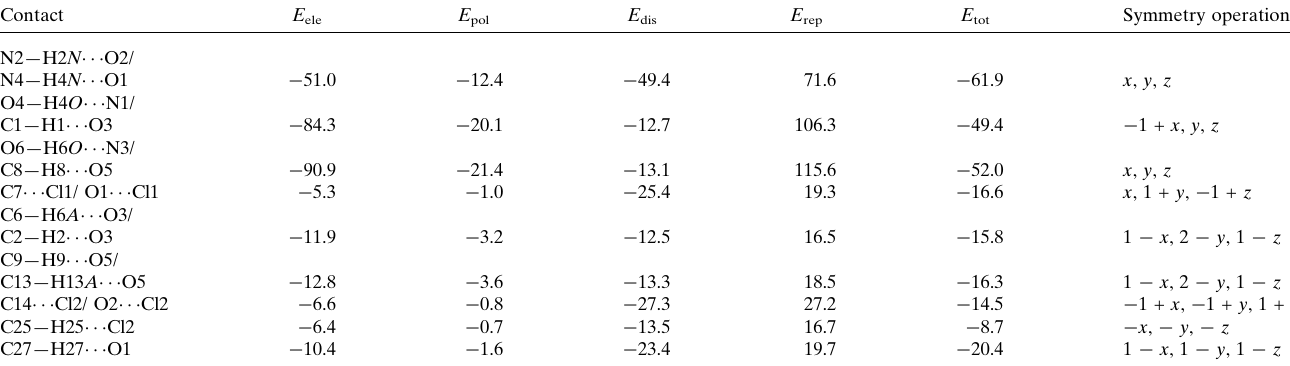
Table 3 A summary of interaction energies (kJ mol 1 ) calculated for (I). Contact E ele E pol E dis E rep E tot Symmetry